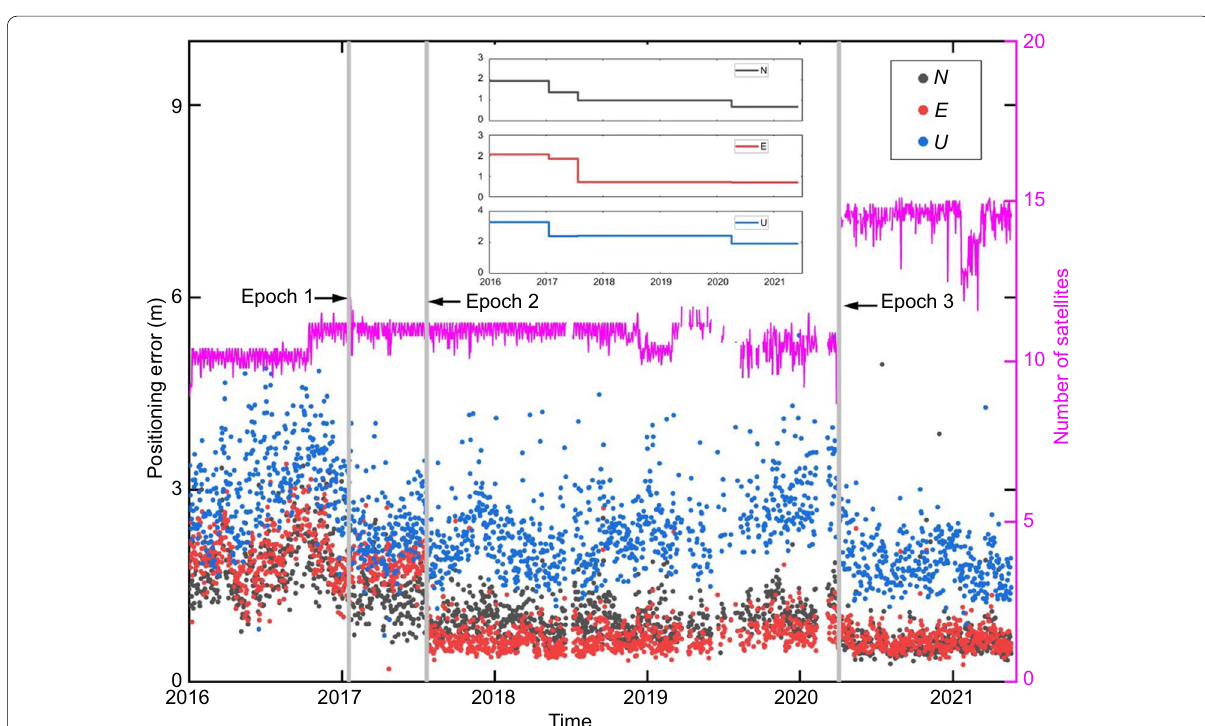
Fig. 9 RMS values of daily SPP position errors at station KARR (Australia) in the north, east, and height component from Jan. 2016 to April 2021 using BDS broadcast ephemeris. Vertical grey lines mark the starting epochs when coordinate accuracy is apparently improved. The pink color illustrates the daily average number of tracked BDS satellites. The zoom-in subplot illustrates the mean positioning errors of each coordinate component during the four different periods